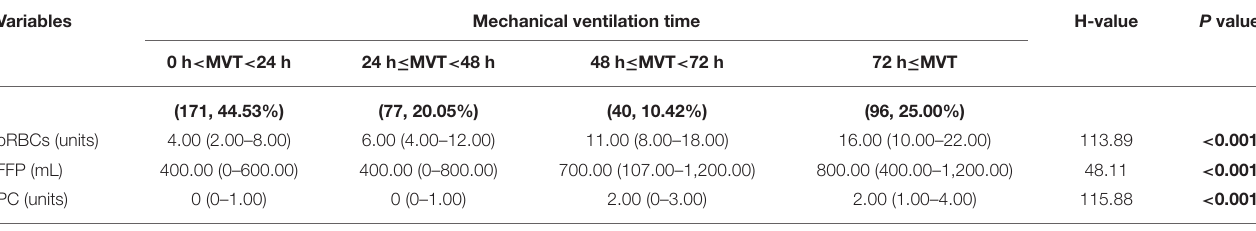
TABLE 3 | The differences in blood products transfusion volume in different MVT.